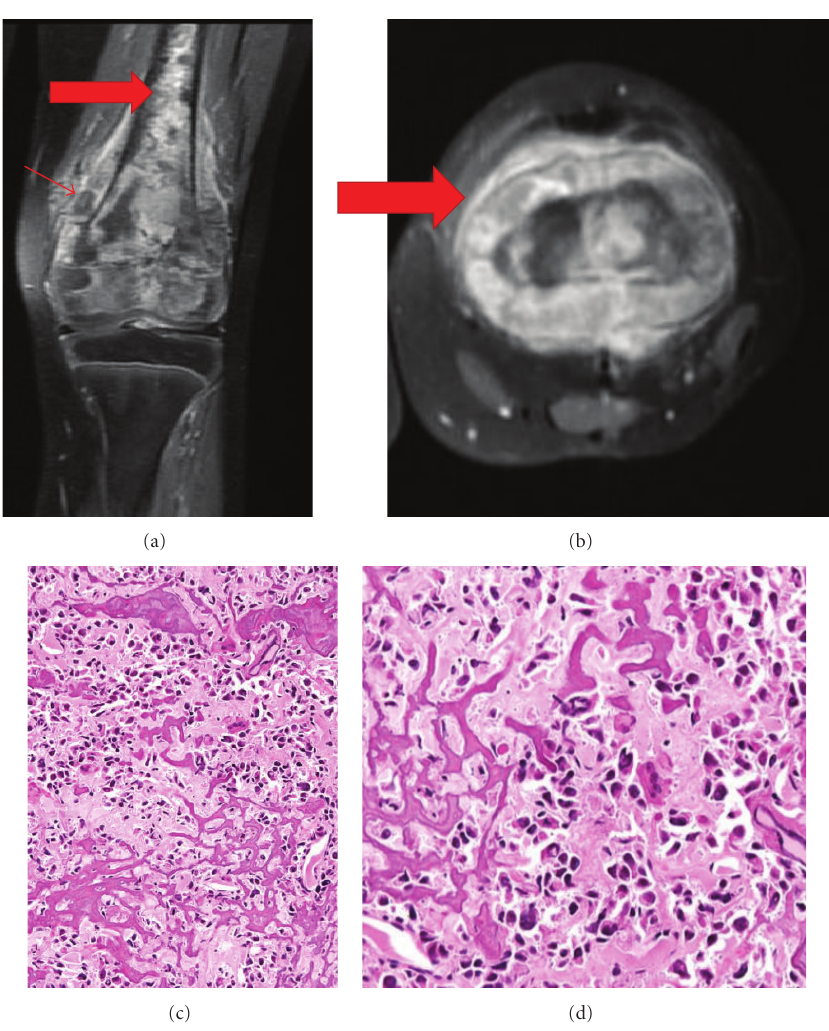
Figure 1: MRI and histological appearance of osteosarcoma. (a) Coronal view MRI reveals di ff use involvement of the distal femur with elevation of the periosteum (small arrow) and di ff use intramedullary involvement (large arrow). (b) Axial view of an MRI reveals elevation of the periosteum due to malignant cells. (c) The classic histological appearance of osteosarcoma. Lace-like pattern osteoid production (small arrow) and malignant cells (large arrow). (d) Higher magnification of (c) to better appreciate the malignant